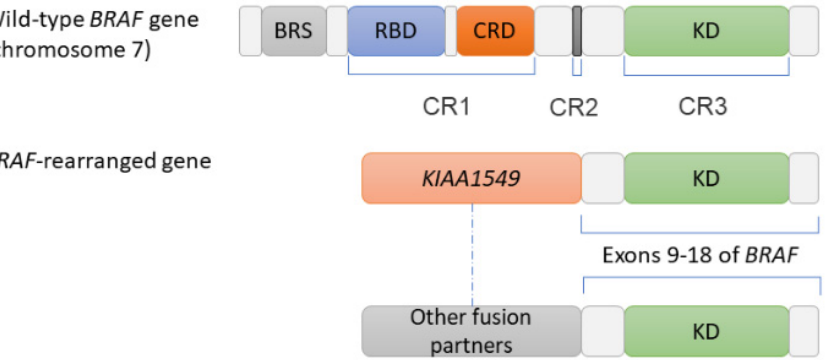
Figure 2. Schematic representation of the wild-type and the rearranged BRAF gene. All BRAF rearrangements lead to a break leaving the serine/threonine kinase domain (or conserved region 3) and the ATP binding pocket of BRAF intact, while the N-terminal domains (conserved region 1